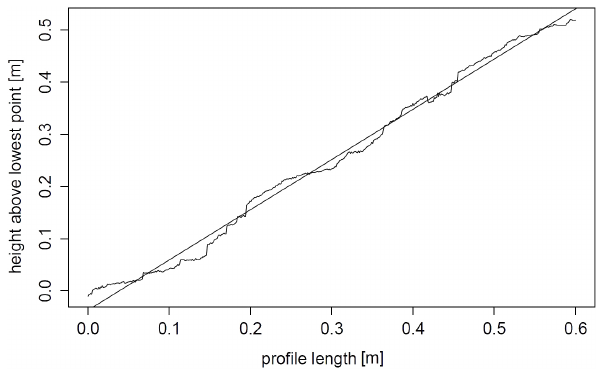
Figure 5. Exemplary profile line for a plot in the Lainbach valley showing the derived soil surface and the inserted best fit line. Table 1. Hydrological parameters ( n Manning, flow velocity, slope and discharge) measured during the experiments for all research sites. Values P1 to P4 were acquired in the Lainbach valley. Hn and Zw are the ones from Saxony, and Flo1 was measured in